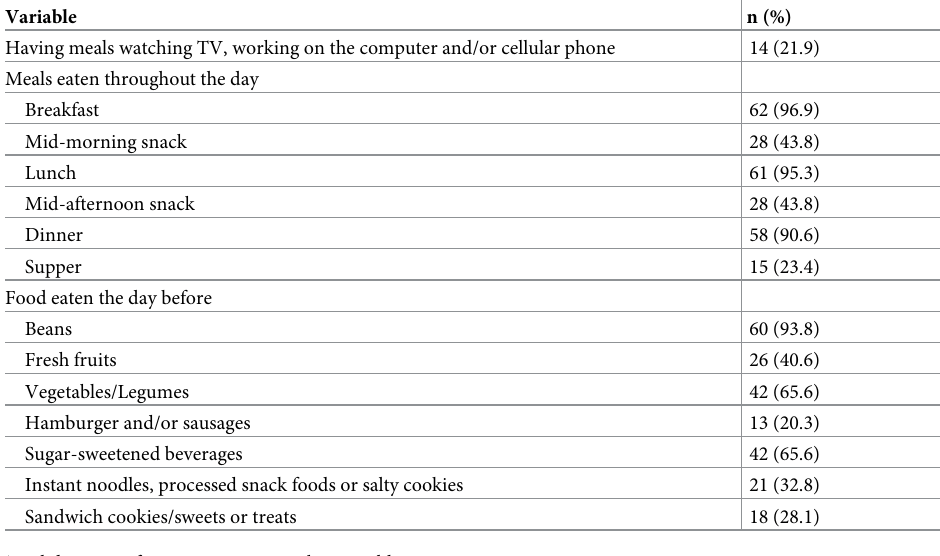
Sandwich cookies/sweets or treats � Valid answers for consumption marker